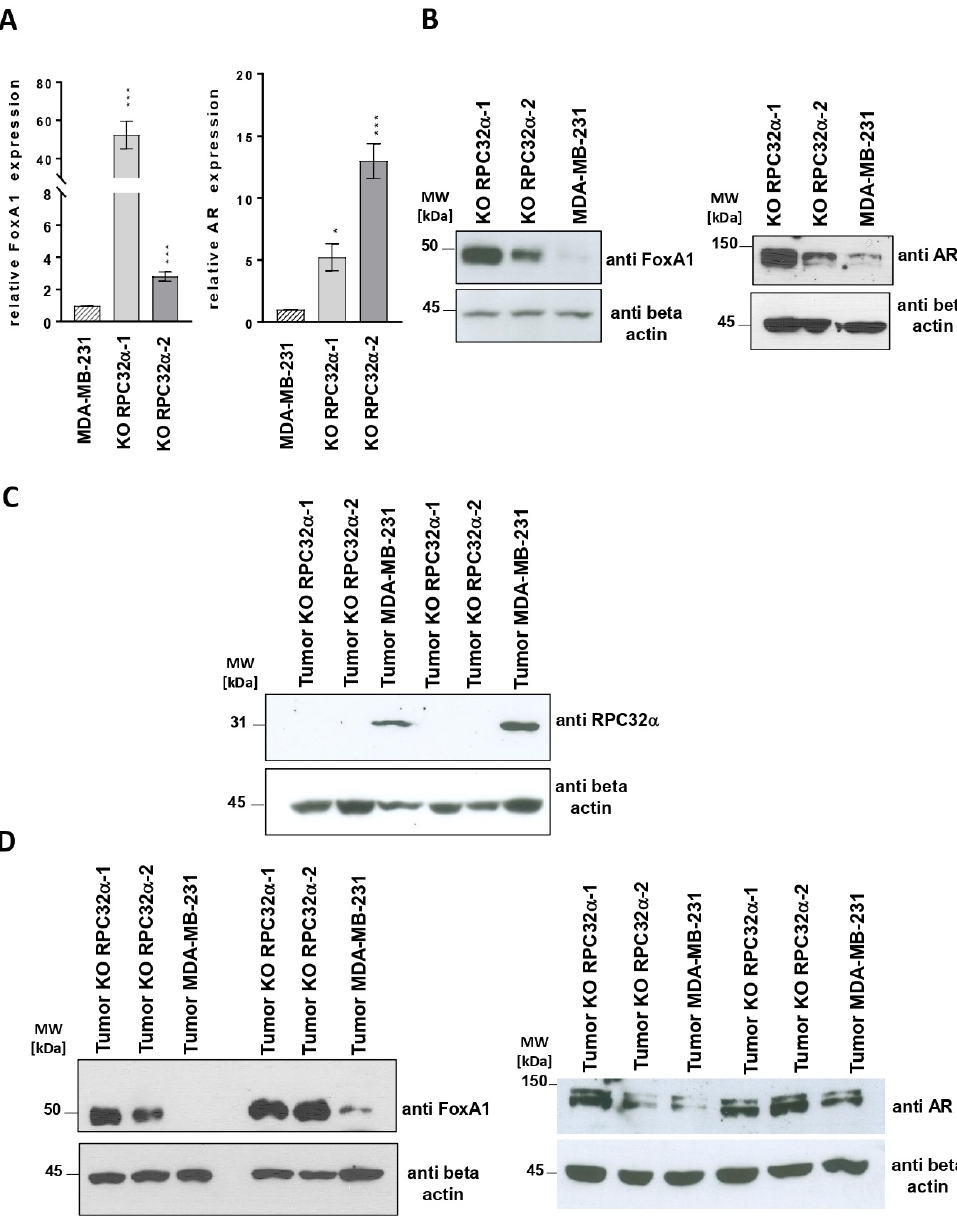
Figure 8. POLR3G/RPC32 α KO induces FOXA1 and androgen receptor (AR) expression. ( A ) RT-qPCR analysis of FOXA1 and AR gene expression in MDA-MB-231 and two POLR3G KO (3GKO) cell lines derived therefrom. Mean relative expression of at least three independent experiments ± SEM is shown (* p < 0.05, *** p < 0.001). The cell lines that were employed are appropriately indicated below the graphs. ( B ) Western blot analyses with anti-FoxA1, -AR and -beta-actin antibodies. Cell lines from which nuclear extracts were derived are appropriately indicated above the ECL images. The proteins that were detected by Western blot are indicated to the right. ( C ) Analyses of RPC32 α and beta-actin expression levels by Western blot in resected tumor samples formed by the cell lines that are appropriately indicated above the ECL images. The proteins that were detected by Western blot are indicated to the right. ( D ) Western blot analysis of FoxA1 and AR expression levels in resected tumors formed by the cell lines that are appropriately indicated above the ECL images. The proteins that were detected by Western blot are indicated to the right of each panel. The uncropped Western Blot images of Figure 8B,C can be found in Figure S6, those of Figure 8D in Figure